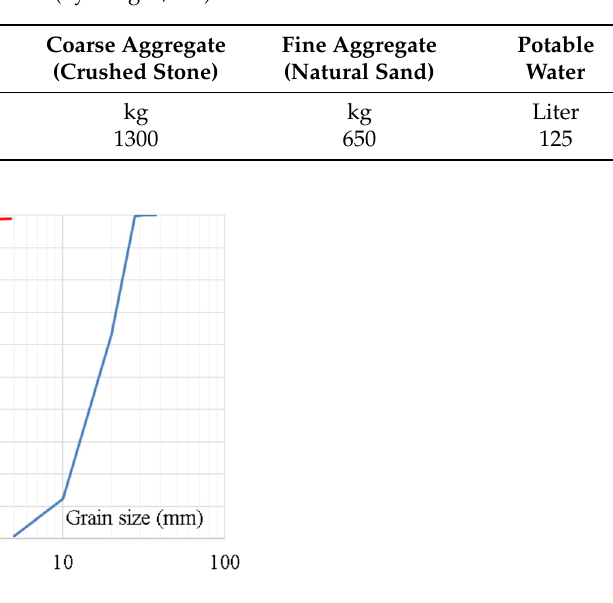
Figure 1. Grain size distribution of fine and coarse aggregates.